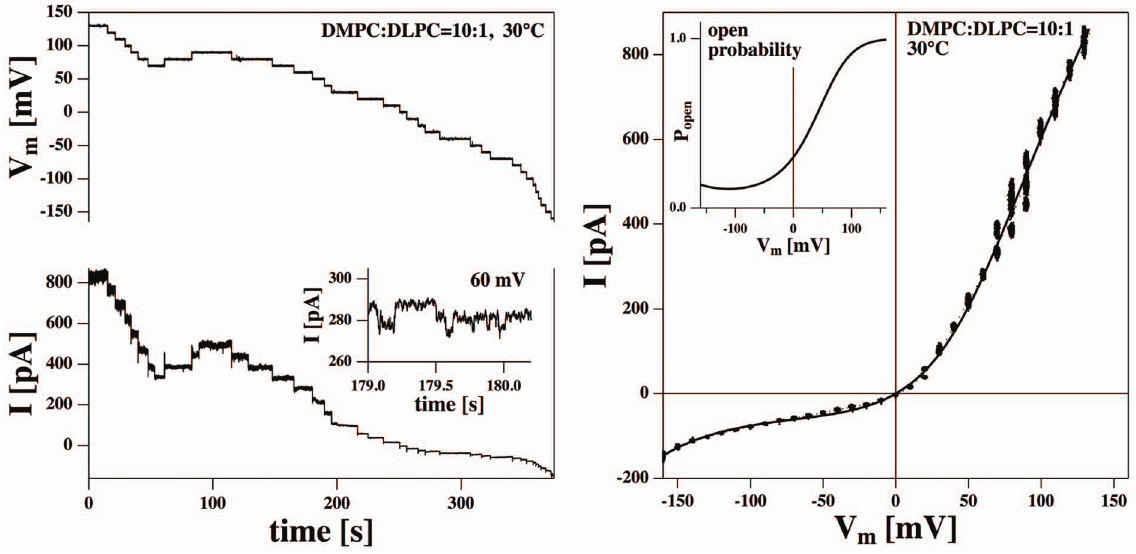
Figure 1. Current-voltage profile of a DMPC:DLPC=10:1 mol:mol membrane at 30 6 C. Left: Membrane voltage and the corresponding total membrane current as a function of time. The voltage was changed stepwise during the experiment. The insert shows some small channel events at V m =60 mV with a conductance of about c =125 pS. Right: Resulting current-voltage relation. The I–V curve is outward rectified. The solid line is a fit to eq. 6 (parameters are given in the text). The insert shows the corresponding open probability of a membrane pore deduced from eq. 5. It displays a minimum at V 0 ~{ 110 mV .